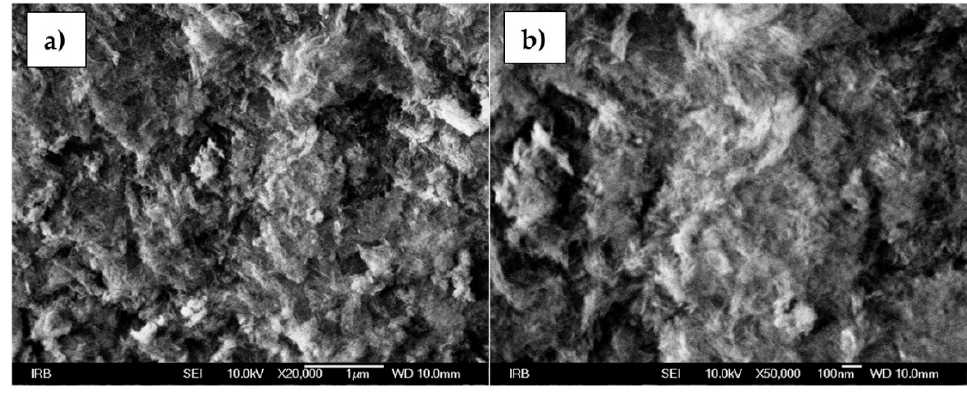
Figure 7. SEM images of alumina NPs at ( a ) 20,000× and ( b ) 50,000× magnification.